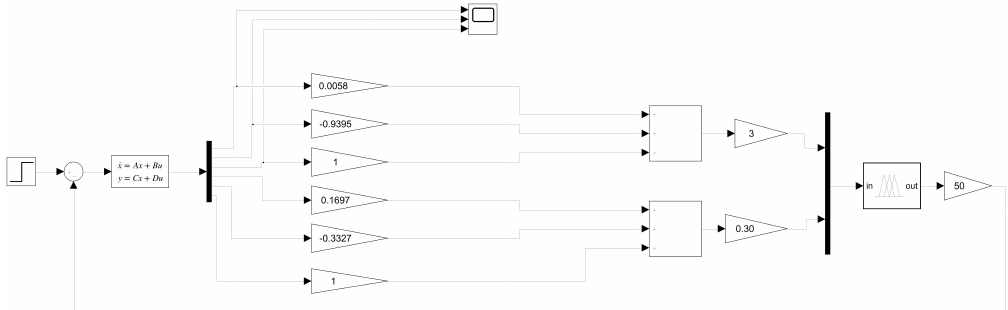
Figure 16. Simulink blocks of the DIP with the FLC (a).